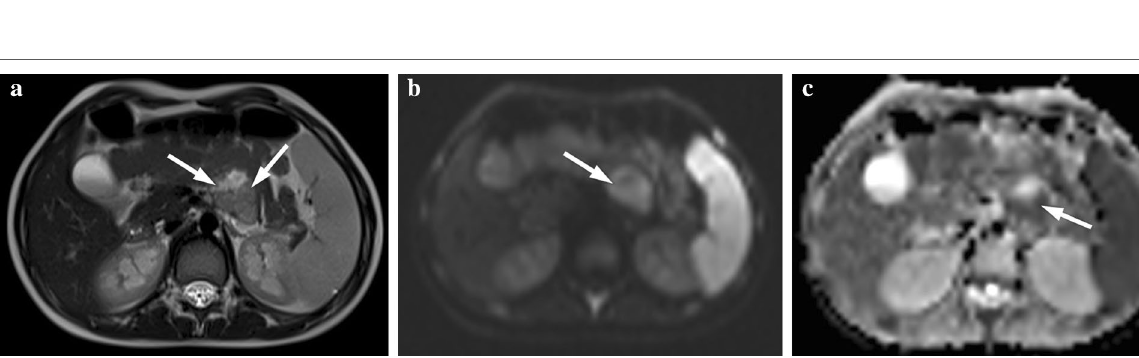
800 s/mm 2 ) and ( c ) =